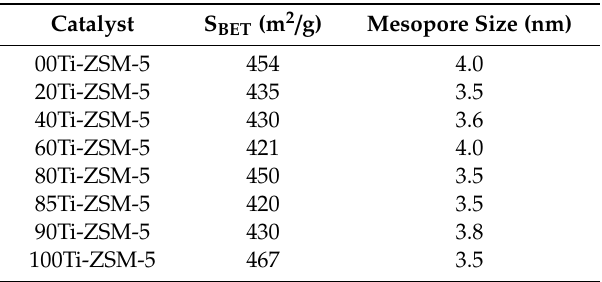
Table 2. Textural properties of hierarchical porous Ti-ZSM-5